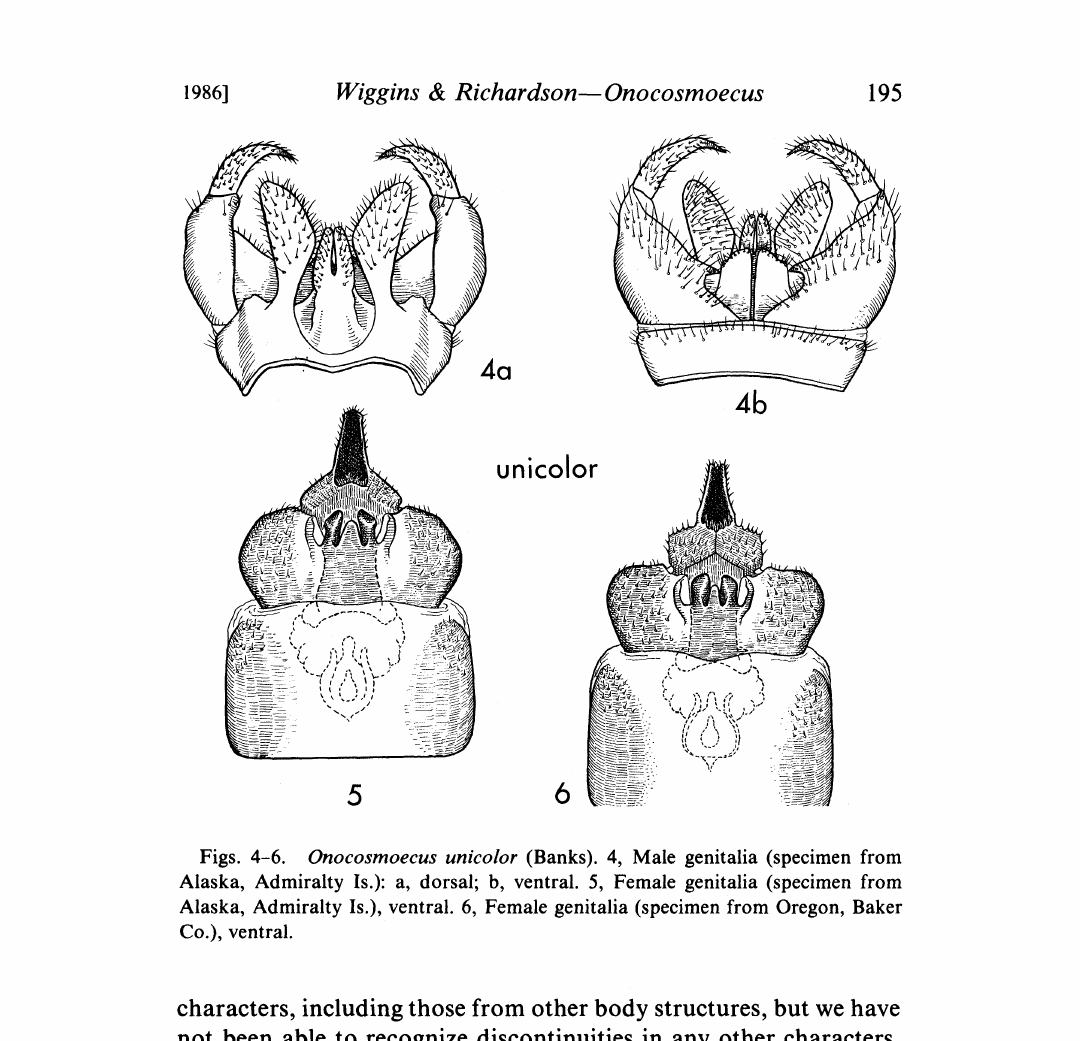
Figs. 4-6. Onocosmoecus unicolor (Banks). 4, Male genitalia (specimen from Alaska, Admiralty Is.): a, dorsal; b, ventral. 5, Female genitalia (specimen from Alaska, Admiralty Is.), ventral. 6, Female genitalia (specimen from Oregon, Baker Co.),